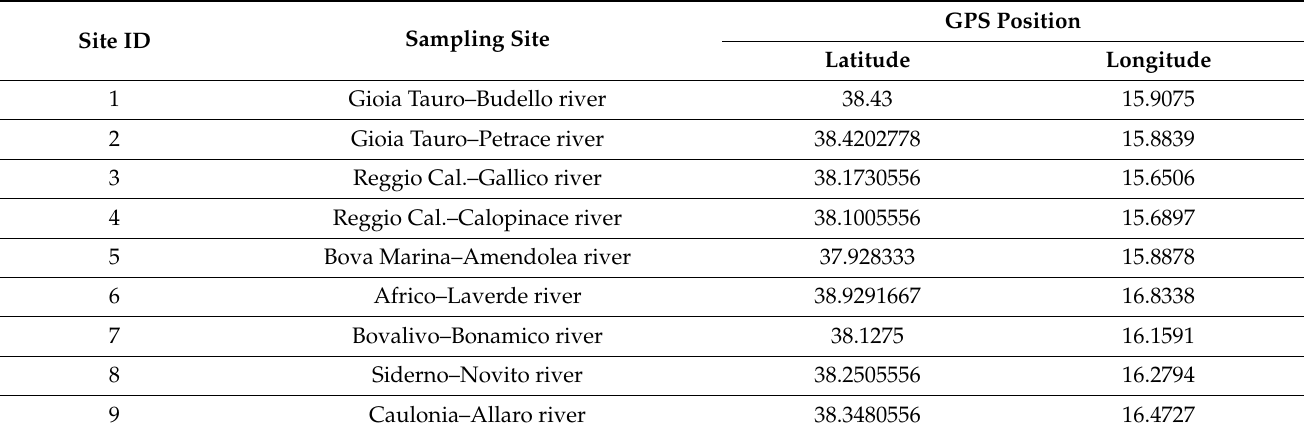
Table 1. Labels and Global Positioning System (GPS) locations of the sampling sites.